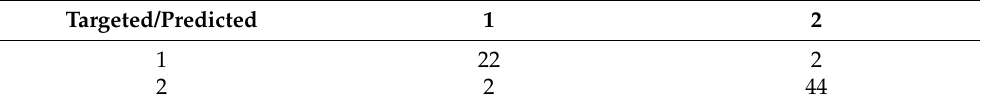
Table 11. The confusion matrix for ConvLSTM architecture on the AIRTLab dataset [18].